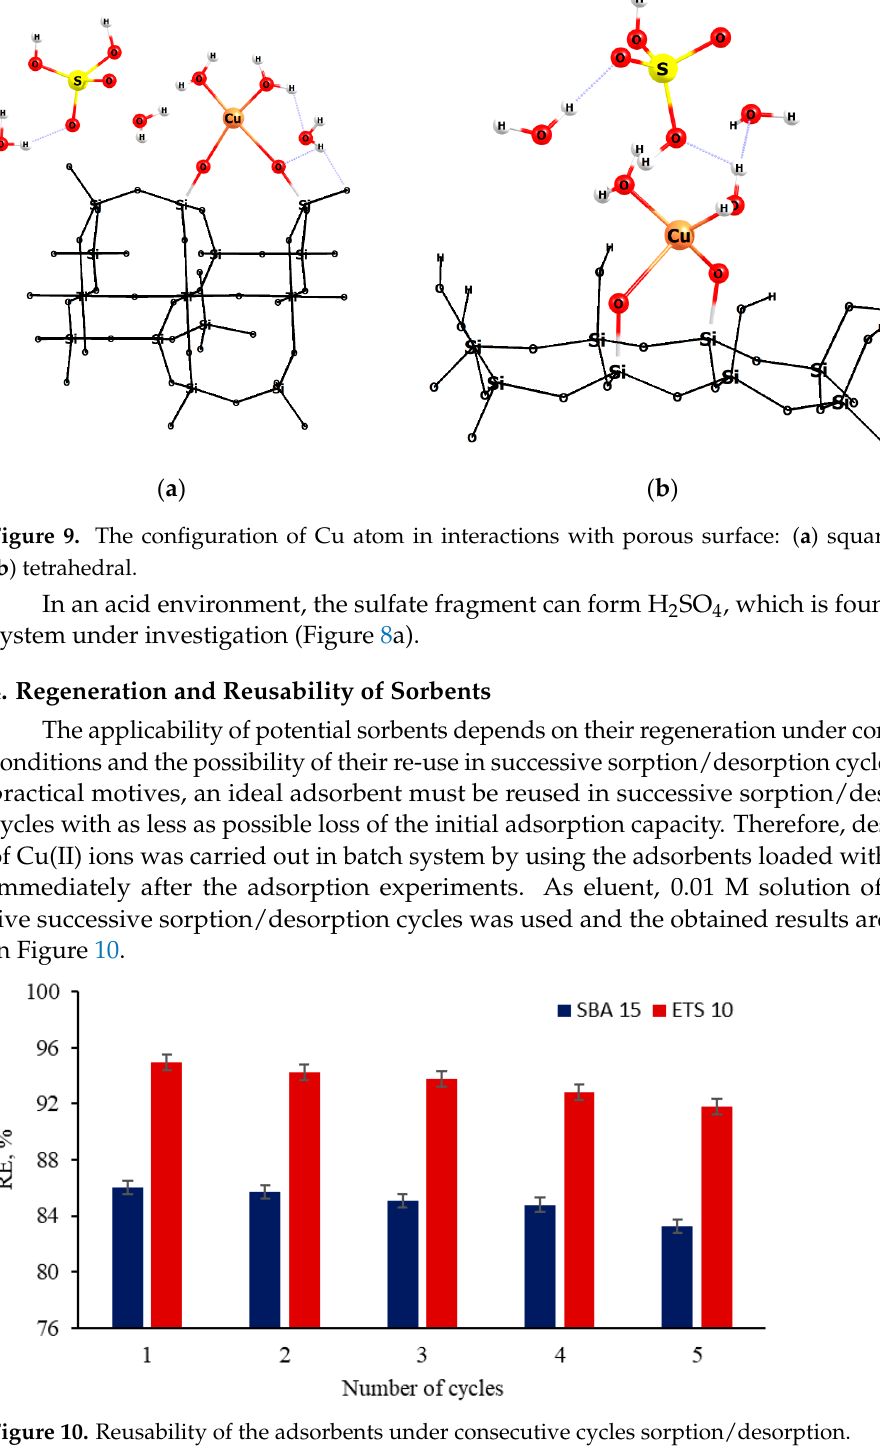
Figure 8. The interaction of the structure CuSO 4 ·5H 2 O with: ( a ) SBA-15, ( b ) ETS-10.